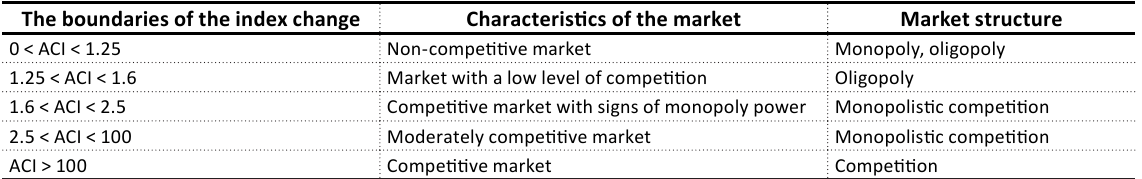
Source: Developed by the